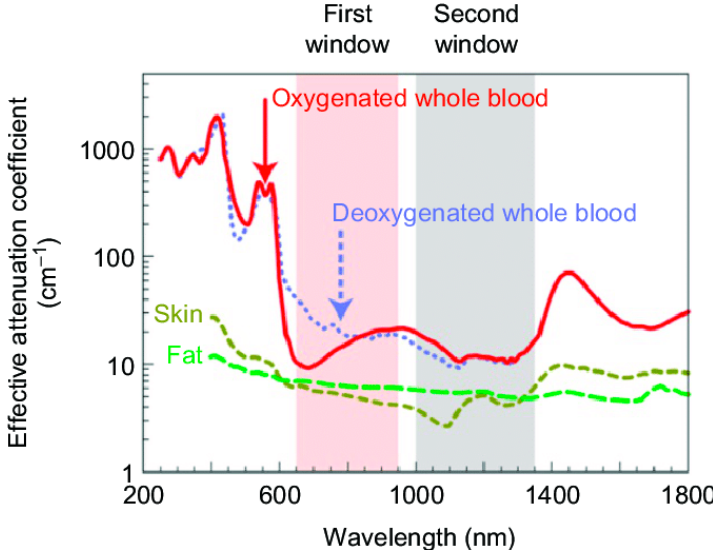
Figure 12. The extinction coefficient of light in different biological components of human tissue [174]. Reprinted (adapted) with permission from [174].